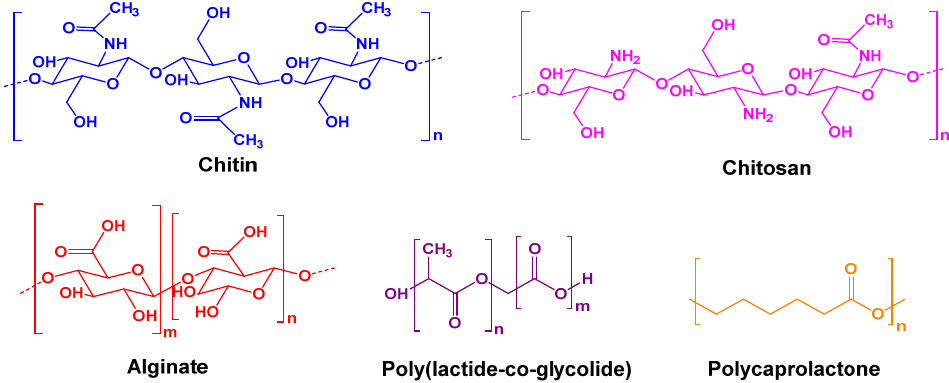
Figure 1. The chemical structures of certain biocompatible hydrogels used for therapeutic enzyme Figure entrapment.